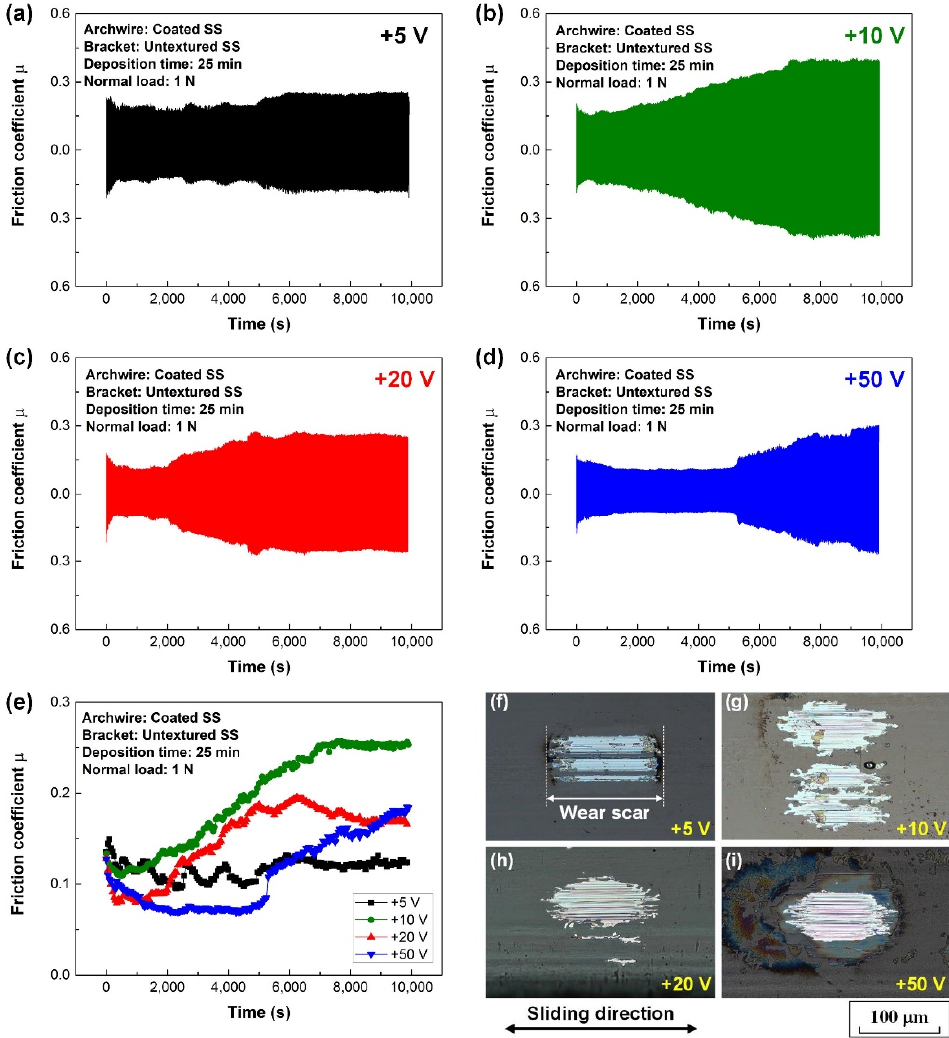
Figure 3. Fretting wear tests of carbon films coated stainless steel archwires running against conventional untextured brackets in artificial saliva environment. Friction curves of carbon films produced at substrate bias voltages of ( a ) +5 V, ( b ) +10 V, ( c ) +20 V, and ( d ) +50 V. ( e ) Average friction coefficients of different carbon films. Optical microscopy images of wear scars on the carbon films fabricated at substrate bias voltages of ( f ) +5 V, ( g ) +10 V, ( h ) +20 V, and ( i ) +50 V.